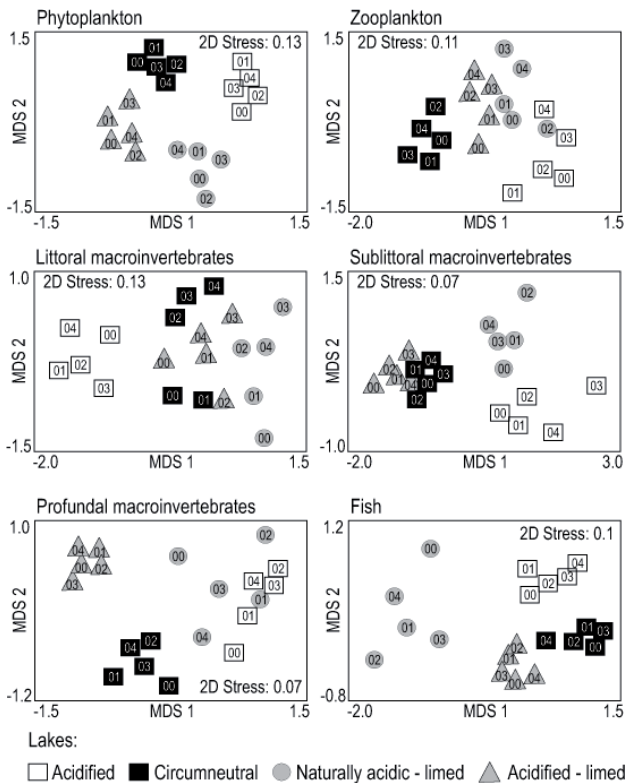
Fig. 3 . Nonmetric multidimensional scaling (MDS) ordinations showing similarities in community structure of phytoplankton, zooplankton, macroinvertebrates in three habitat types (littoral, sublittoral, profundal) and fish between lake types. Stress values < 0.15 means reliable ordination